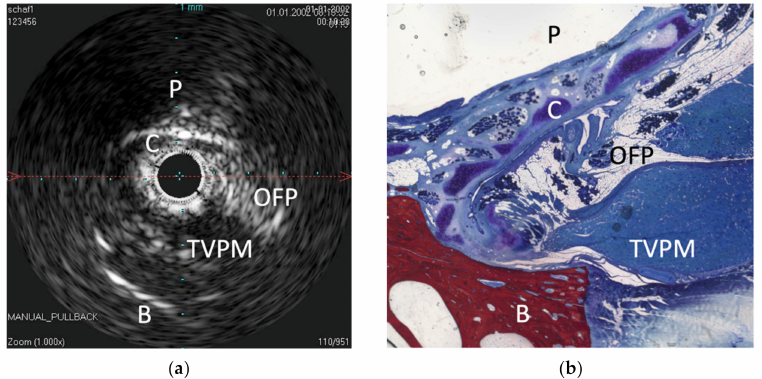
Figure 1. Comparison of the sonographic cross-sectional image near the nasopharyngeal ostium with the histology. ( a ) Sonographic cross-sectional image of the ET lumen near the nasopharyngeal ostium. Note the higher echogenicity of the lining mucosa in the collapsed state of the ET and the sound extinction through bone and air (pharynx). The cartilage (C) is anechogenic. ( b ) Histologic image of this corresponding area. C—cartilage, TVPM—tensor veli palatini muscle, B—bone, P—pharynx, OFP—Ostmann fat